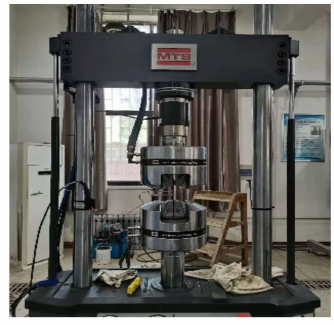
Figure 8. MTS 370.25.